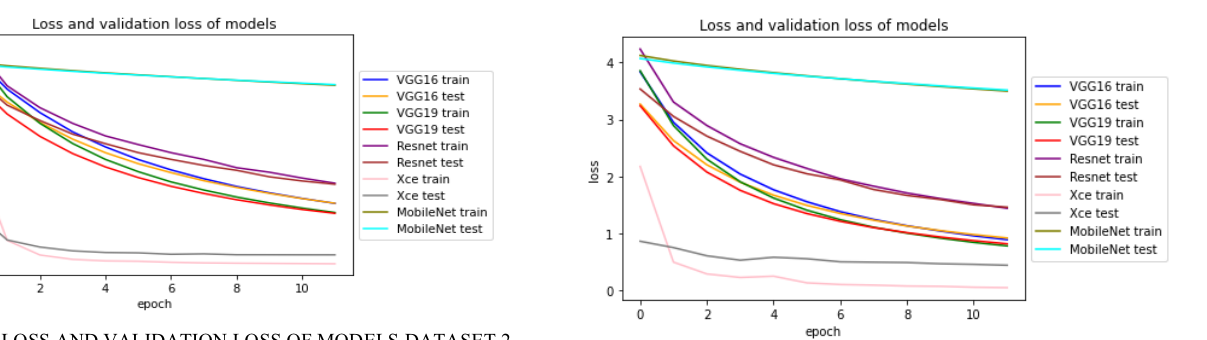
FIGURE IX. LOSS AND VALIDATION LOSS OF MODELS DATASET 2 Figure IX represent how loss (train) and validation loss